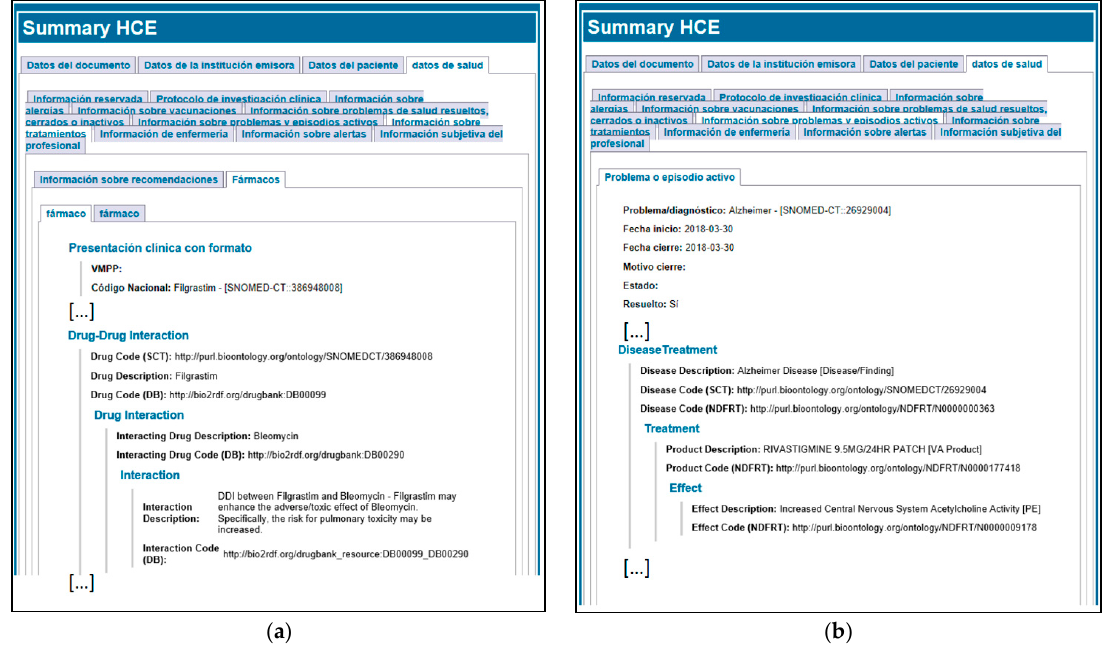
Figure 15. An HTML representation of the augmented summary EHR extract, an instance of the augmented archetype CEN ‐ EN13606 ‐ COMPOSITION.HistoriaClinicaResumidaAugmented.v1 including the augmented content from ( a ) drug– drug interactions’ and ( b ) disease ‐ related treatments’ EHR augmentations.